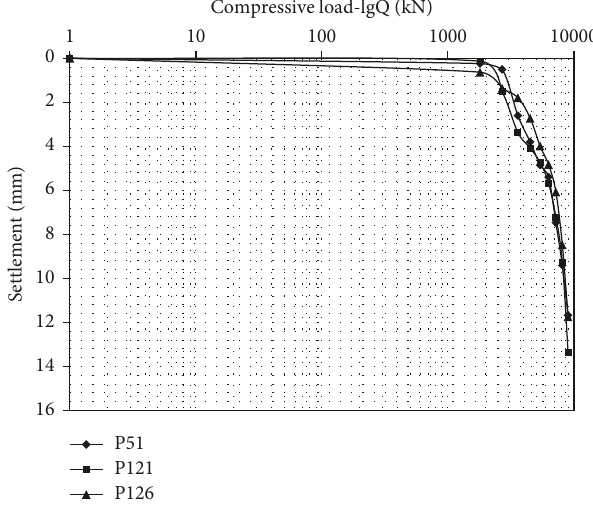
Figure 5: Dynamic load test setup.